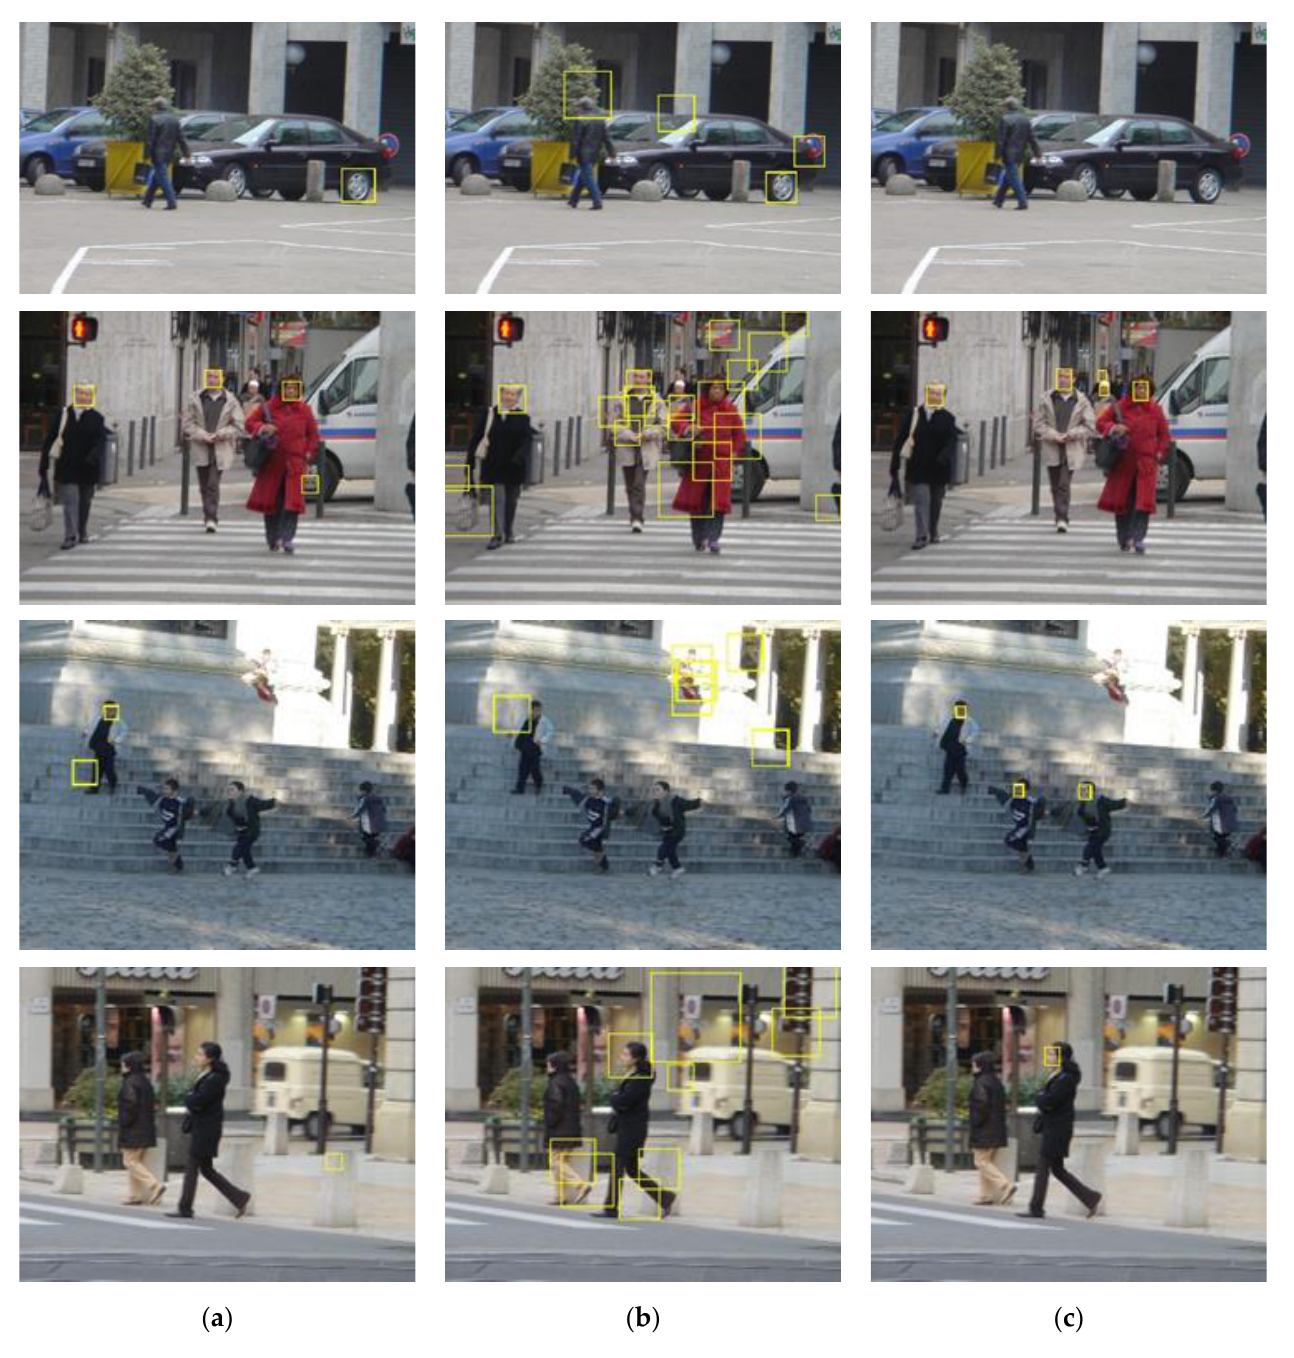
Figure 5. Face detection results of sample images using the VJ face detector ( a ), the fast face detector ( b ), and the MTCNN detector ( c ).